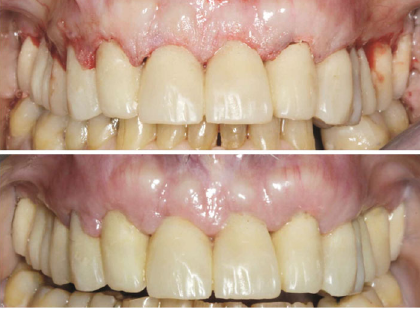
Figure 8: The interim restoration immediately after the prosthetic procedure and after one month of soft tissue maturation.